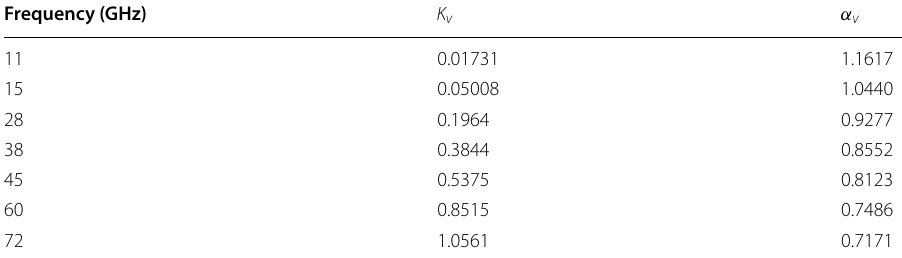
Table 1 Coefficients for K v and α v for indicated frequency of